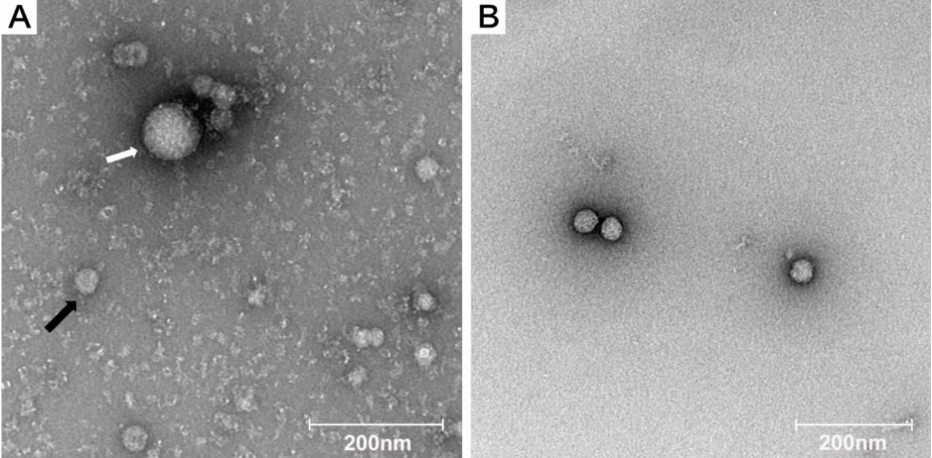
Figure 2. Electron microscopy of wild ( A ) and rescued ( B ) mosquito flavivirus. ( A ) Two types of virions were observed with diameters of 70–80 nm (white arrow) and 30–40 nm (black arrow). ( B ) The diameter of rMFV YN15-283-02 was around 30–40 nm. Scare bar = 200